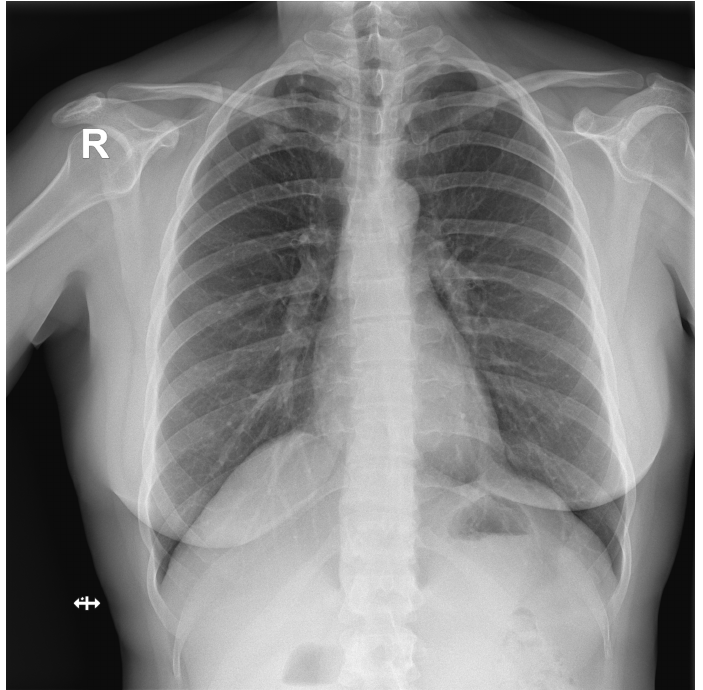
Figure A2. False Negative image #1 incorrectly classified by DLAD software during the retrospective study. The software failed to detect a lesion in lung parenchyma. Assessed radiologists #5f0 and #24a also incorrectly classified this image as Normal.